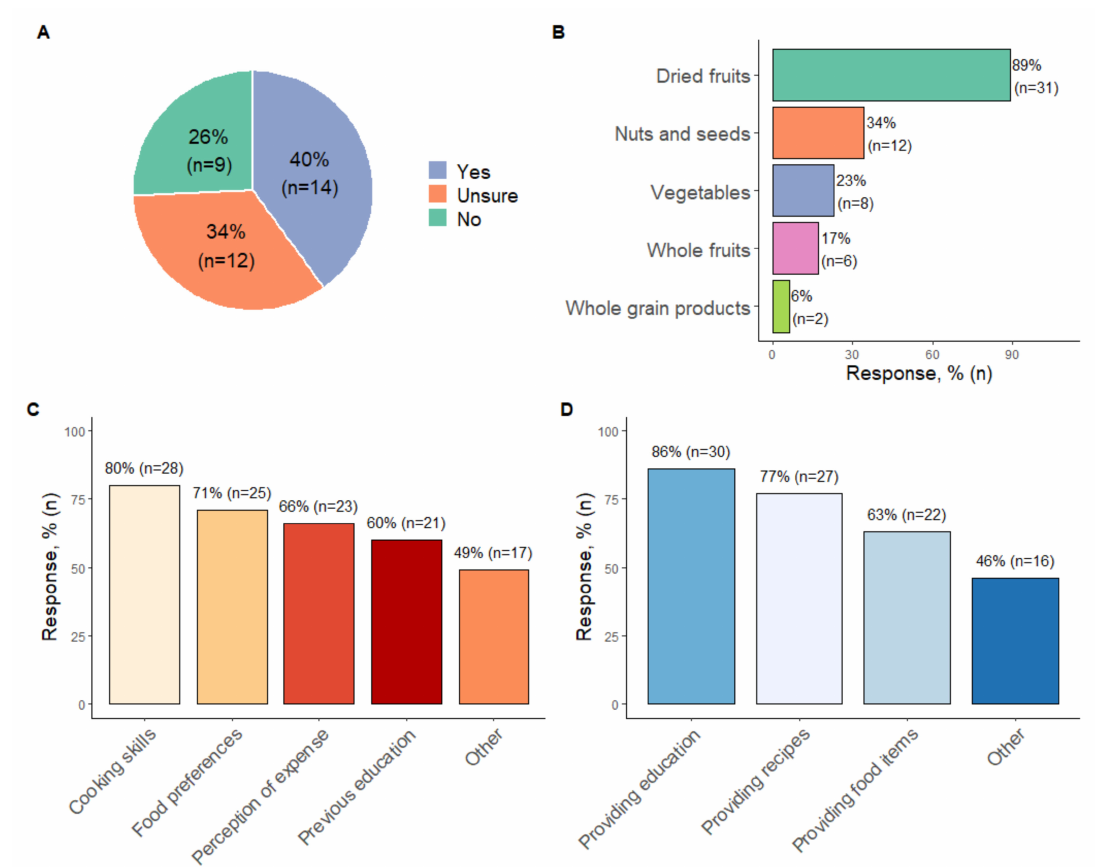
Figure 1. Summary of responses to multiple-choice survey questions. ( A ) Answers to whether the target of consuming 30 unique plant-based foods over seven days is realistic for patients with CKD. ( B ) Responses to the question about which plant foods dietitians felt cautious about prescribing to people with CKD. ( C ) Potential challenges to implementing plant-based diets for people with CKD. ( D ) Potential enablers to implementing plant-based diets for people with CKD. Multiple responses were accepted for the questions presented in figures ( B – D